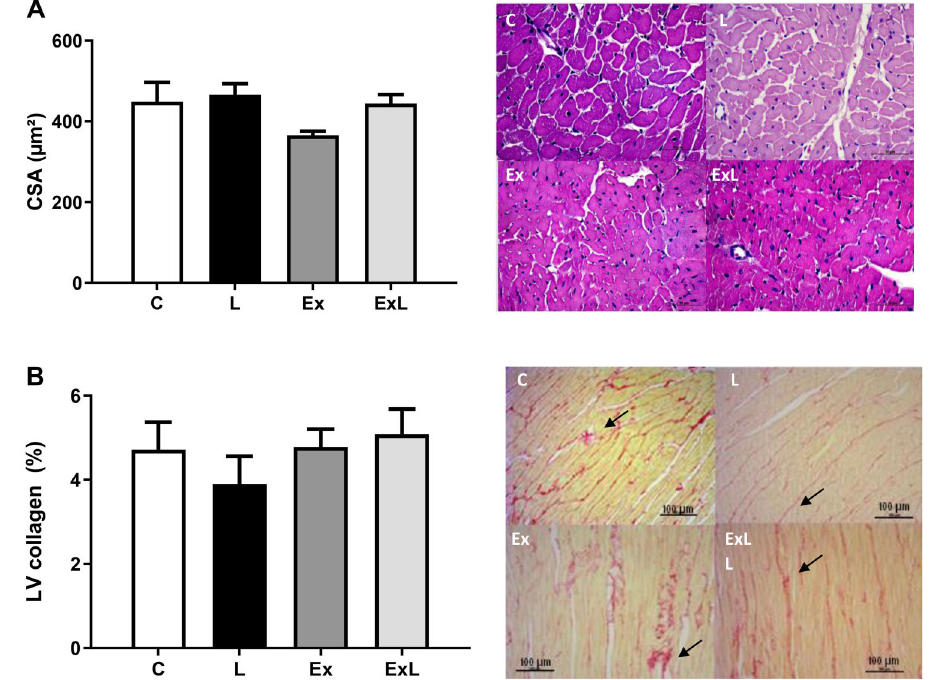
Figure 4. Histological studies performed in C: Control (n=6); L: low-dose administration of L-NAME (n=7); Ex: chronic aerobic exercise (n=5); ExL: chronic aerobic exercise and low-dose administration of L-NAME (n=10). LV: A , CSA: cross-sectional area obtained by HE staining for reticulin (magni fi cation 40 (cid:3) , magni fi cation bar 50 m m). B , Interstitial collagen of myocardium in representative picrosirius red-stained left ventricle (LV) section (magni fi cation 20 (cid:3) , magni fi cation bar 100 m m). Arrows: interstitial collagen. Data are reported as mean ± SEM. P 4 0.05, two-way ANOVA followed by Tukey ’ s post-hoc